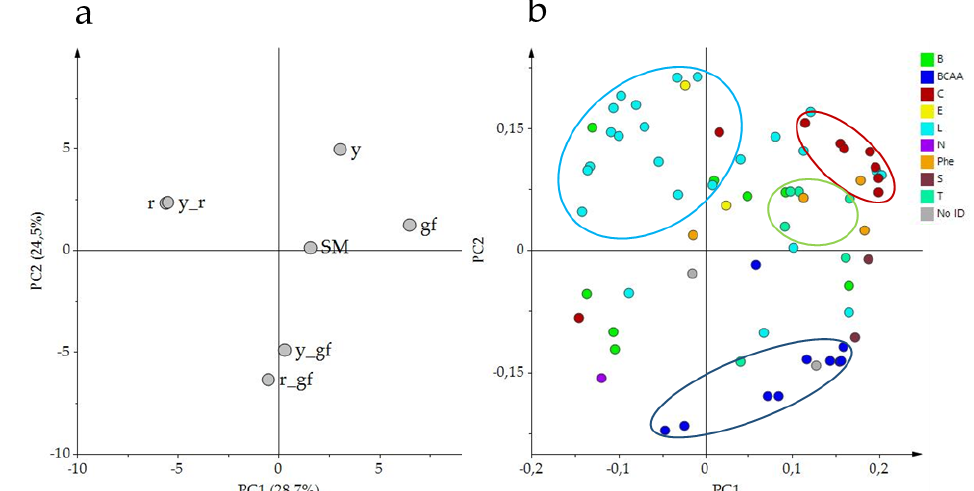
Figure 2. PCA of log2 values of 68 volatile compounds measured by a solid-phase micro-extraction gas-chromatography coupled to mass spectrometry (HS-SPME / GC-MS). ( a ) PC1 × PC2 score plot of the six mutated lines plus San Marzano (SM). ( b ) PC1 X PC2 loading plot. Line (a) and metabolite class (b) abbreviations are explained in Tables 1 and 2